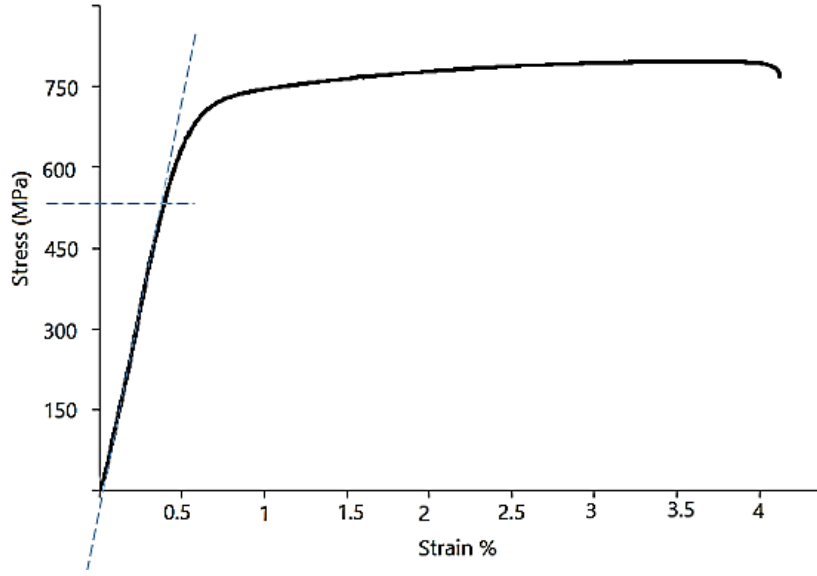
Figure 9. Conventional curve of AISI1045 steel.